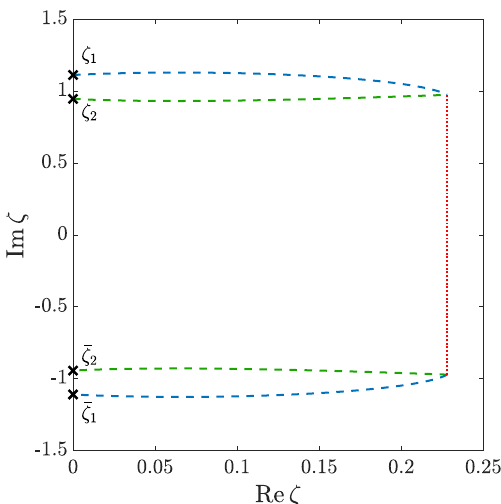
Figure 10: Quantised bion configuration with the proposed density contours (phys- ical cuts). The two nonlinear modes with δ = 1, parametrised by pairs of branch ) and ( ζ ) on imaginary ζ -axis, have associated mode numbers points ( ζ , ¯ ζ , ¯ ζ 1 1 2 2 = 1 and n = − 1. The branch points have been found numerically and are lo- n 1 2 = ( 1 / 0.9 ) i and ζ = ( 1 / 1.058355921 ) i, The red dashed line cated at ζ 1 2